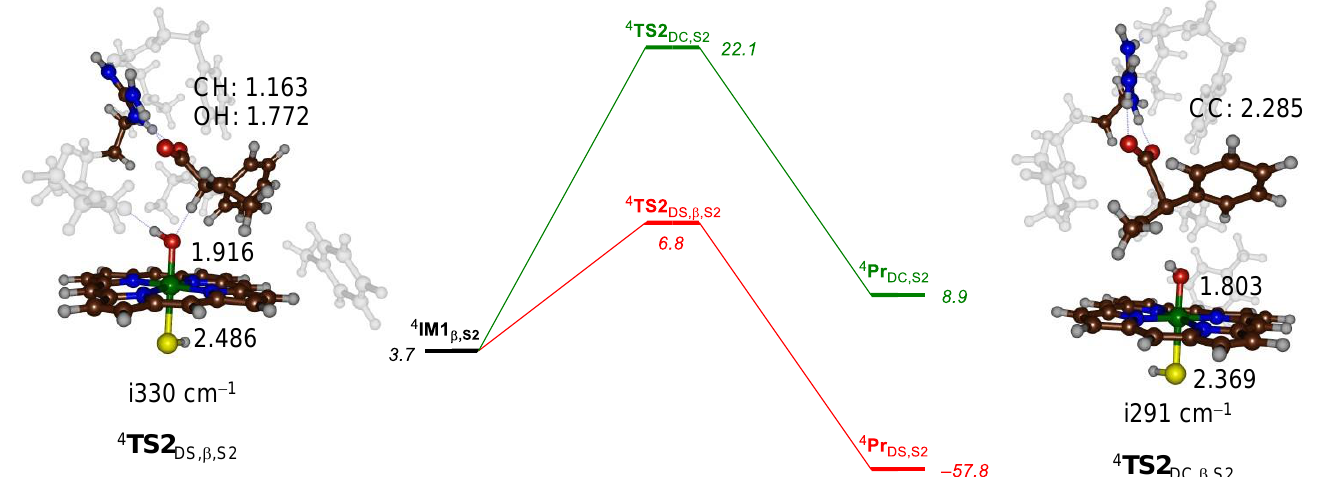
Figure 8. Substrate desaturation and decarboxylation bifurcation pathways for substrate S2 from the radical intermediate IM1 β ,S2 of P450 OleT JE . The energy landscape gives energies relative to 4 R e S2 in kcal mol − 1 as obtained at the ∆ E+ZPE level of theory. Transition state structures are shown with bond lengths in angstroms and the imaginary frequency in the transition state in cm − 1 .